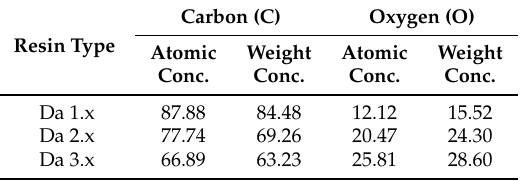
Table 3. The evolution of the carbon and oxygen in the composition of the three types of